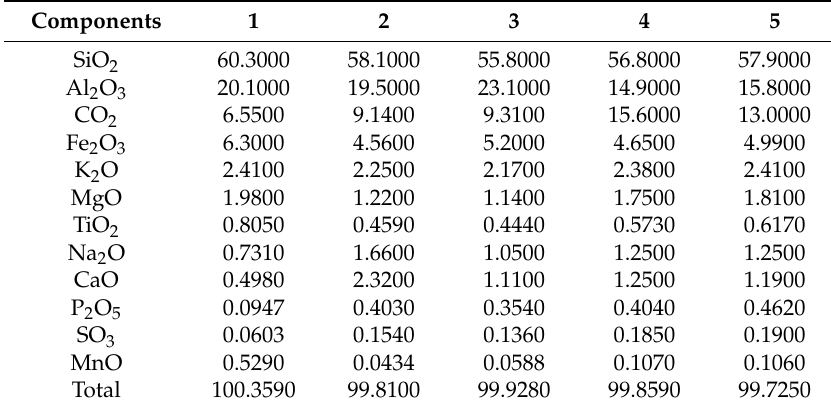
Table 6. Results of XRF analyses of sediments in Makiyama agricultural reservoir pond, Kanazawa, Japan (mass